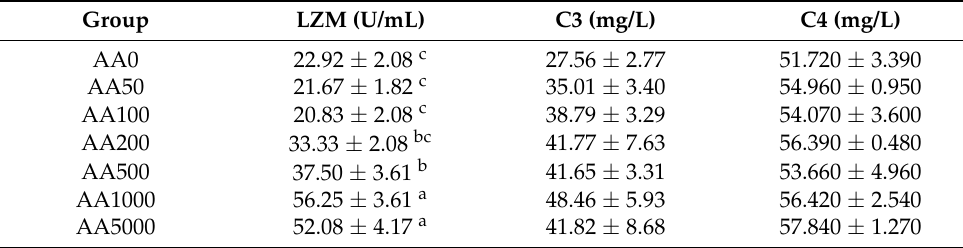
Table 4. Effects of dietary ascorbic acid on the lysozyme activity, C3 and C4 content in cell-free